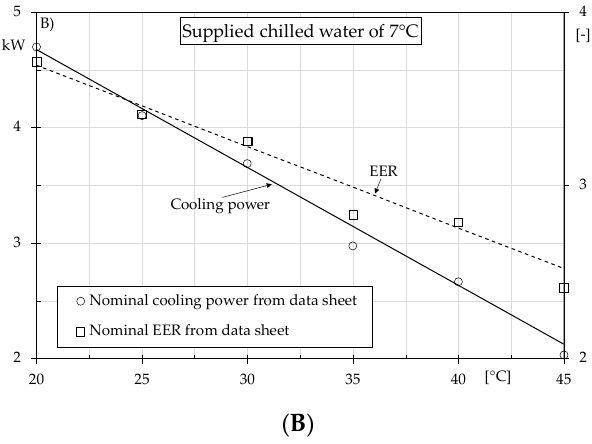
Figure 3. Manufacturer data and linearized trends for the thermal power and the COP ( A ) and for the cooling power and EER ( B ).